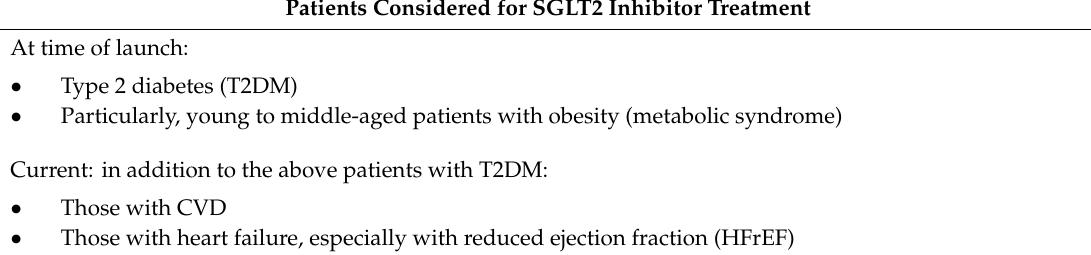
Table 4. Patients considered for SGLT2 inhibitor treatment in the past, the present, and the future. Patients Considered for SGLT2 Inhibitor Treatment